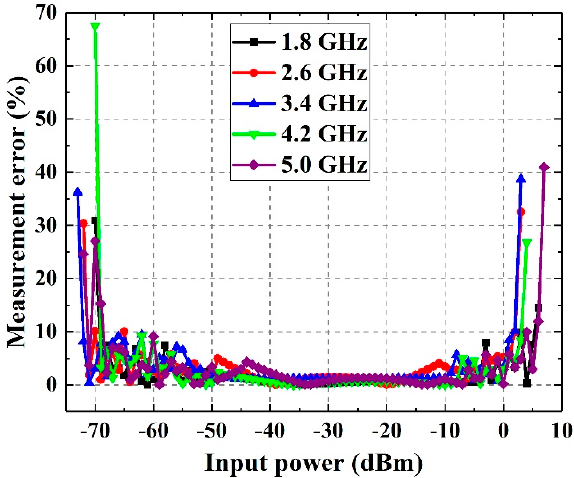
Figure 11. Measurement error of the detection system.